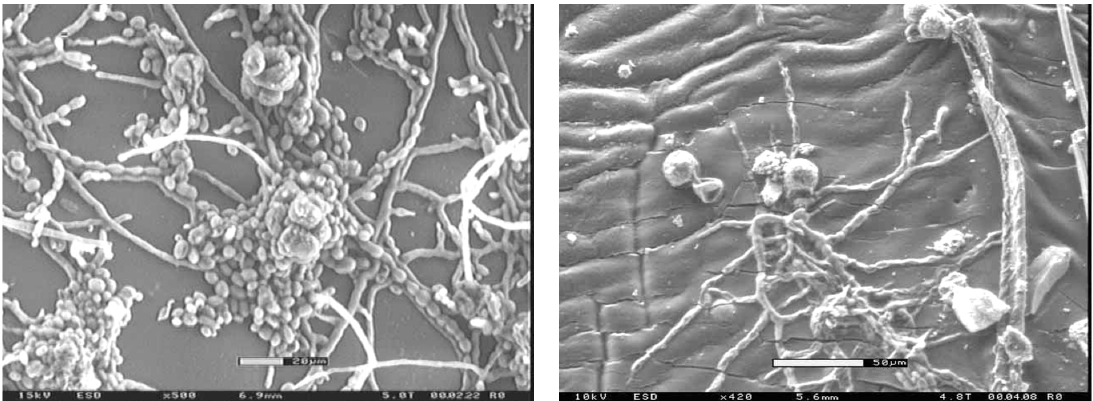
Figure 3. Scanning electron micrographs showing ( a ) fungal spores and hyphae growing on the surface of a new coating surface and ( b ) fungal spores and hyphae growing on an aged coating surface containing microcracks that can be exploited by fungal hyphae (Goodell images).